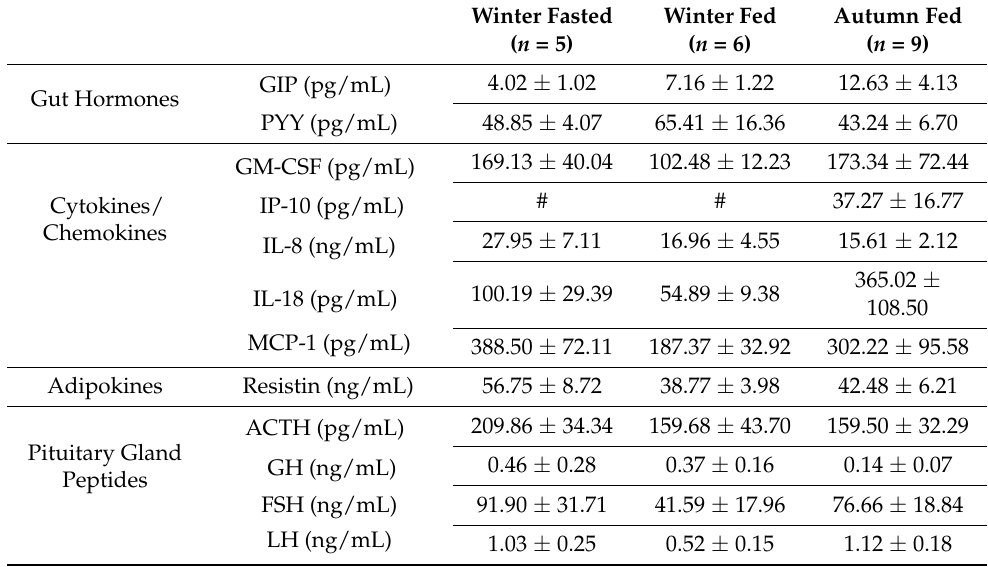
Table 2. Measured plasma metabolites. Symbol # indicates values under assay detection limit and could not be